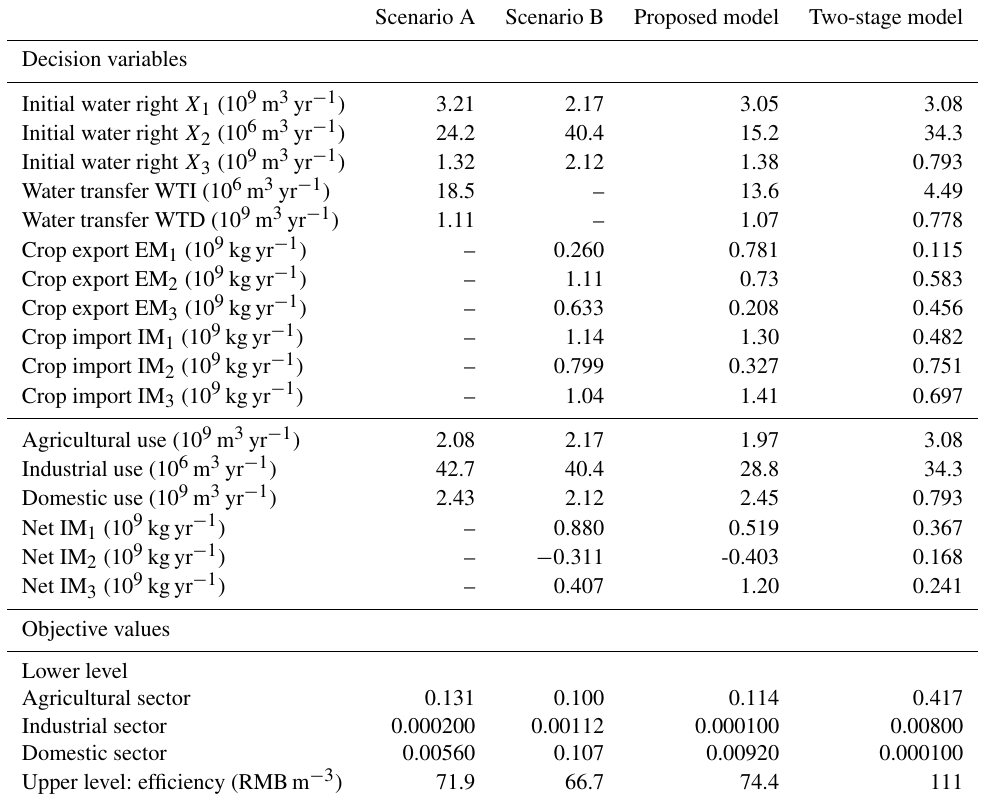
Table 4. Comparison results under different